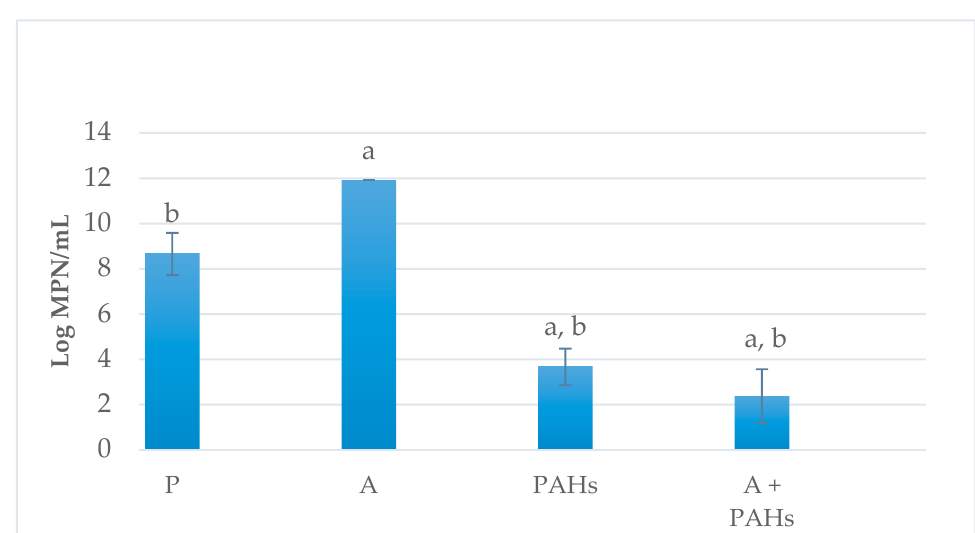
Figure 2. Abundance of hydrocarbons degraders, evaluated by the most-probable number (MPN) method, in the cultures inoculated with the mixture of 5 bacterial strains CPN1-CPN5 (mean value, standard deviation, n = 3) grown with different carbon sources: petroleum (P), sodium acetate (A), a mixture of polycyclic aromatic hydrocarbons (PAHs) and a combination of sodium acetate with a mixture of PAHs (A + PAHs). a—significant differences comparing with the P treatment; b—significant differences compared with the A treatment.